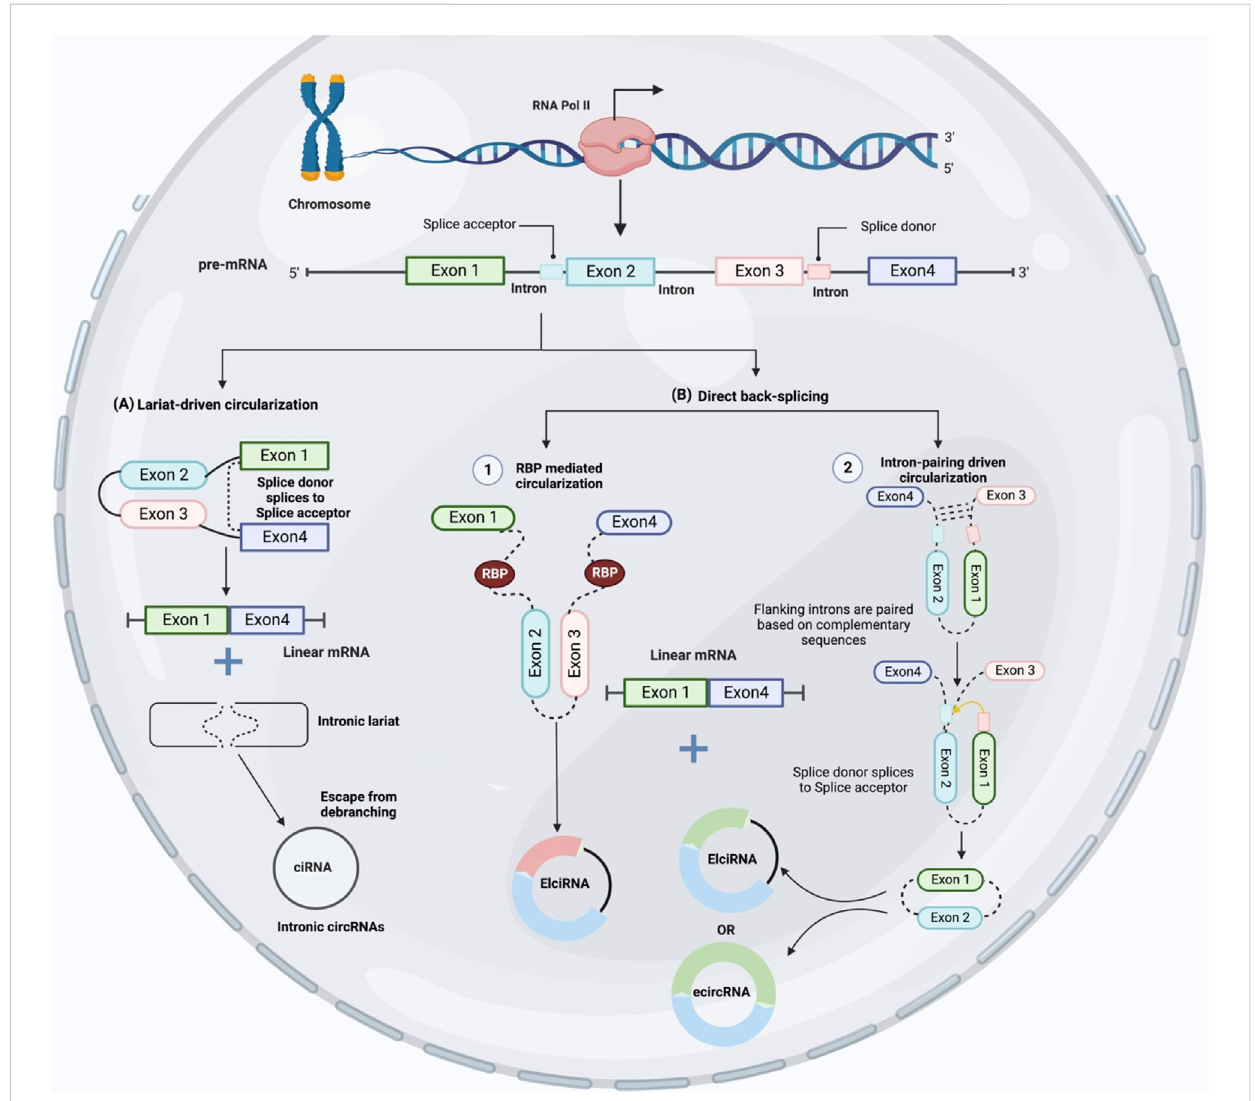
FIGURE 2 CircRNAbiogenesis. (A) ExonskippingcreatesanmRNAwithexonsoneandfourandalariatstructureorintroniclariatescapefromdebranchingand produced intronic circRNAs (ciRNAs). (B) Back-splicing occurs initially, followed by further processing to create linear mRNA from circRNA with exons andintrons.The fi rsttype,called “ intron-pairingdrivencircularization, ” occurswhencomplementary segmentsoneithersideofanintronpairuptocarry thesplicesitesclosertogetherandfacilitatecircularization.Thesecondtype,called “ RBPmediatedcircularization, ” occurswhenRBPsbindwiththe intron binding sites to bring the splice sites closer together and initiate